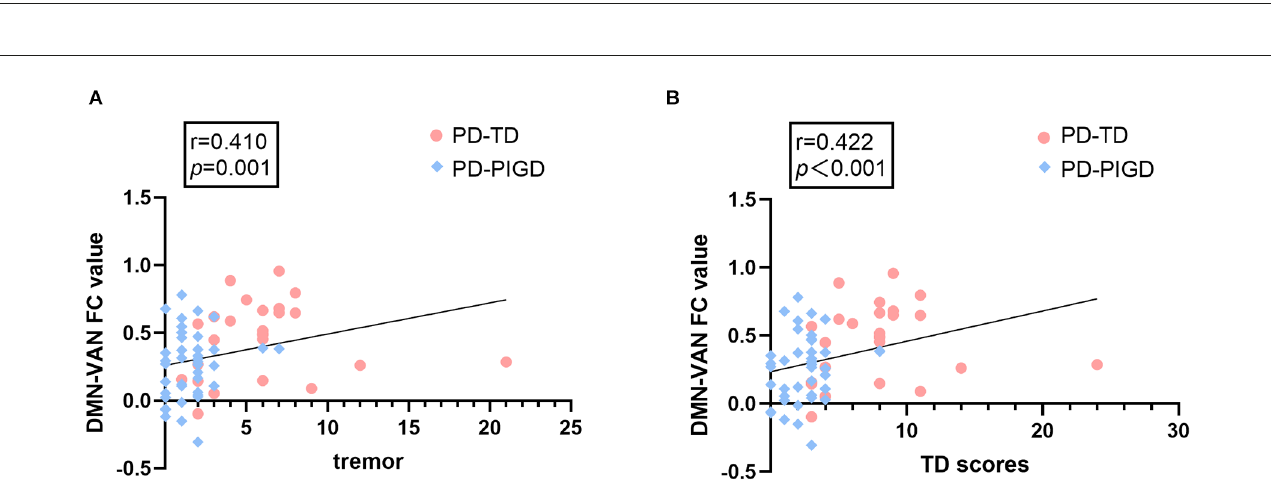
FIGURE3 The correlations between internetwork connectivity and tremor and TD scores in PD patients. (A) FC between the default mode network (DMN) and ventral attention network (VAN) shows a significant positive correlation with tremor scores ( p = 0.001). (B) FC between DMN and VAN shows a significant positive correlation with TD scores ( p <